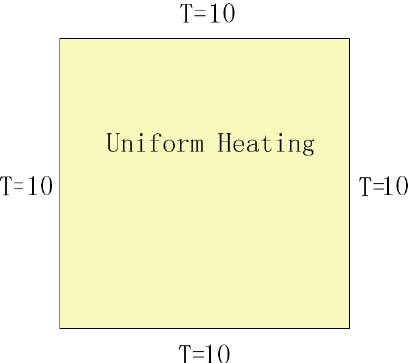
Fig. 1. A square plate with uniformly distributed heat re- source and boundaries with prescribed